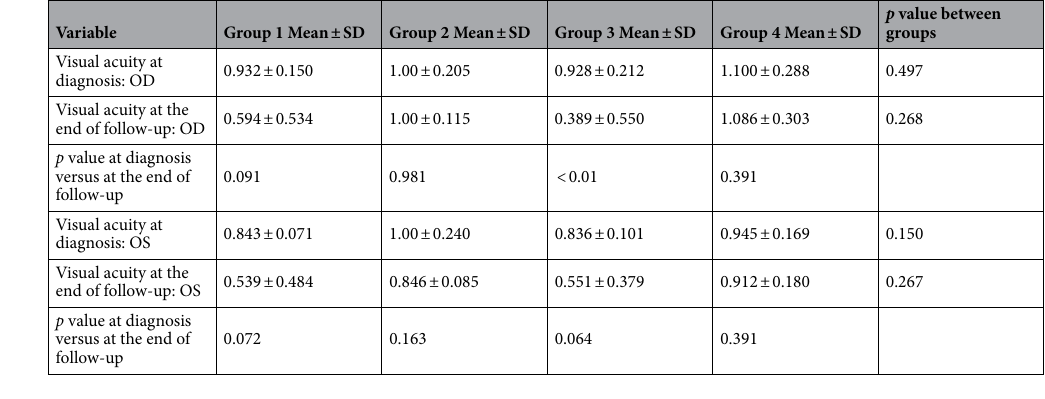
Table 5. Visual acuity at diagnosis versus at the end of